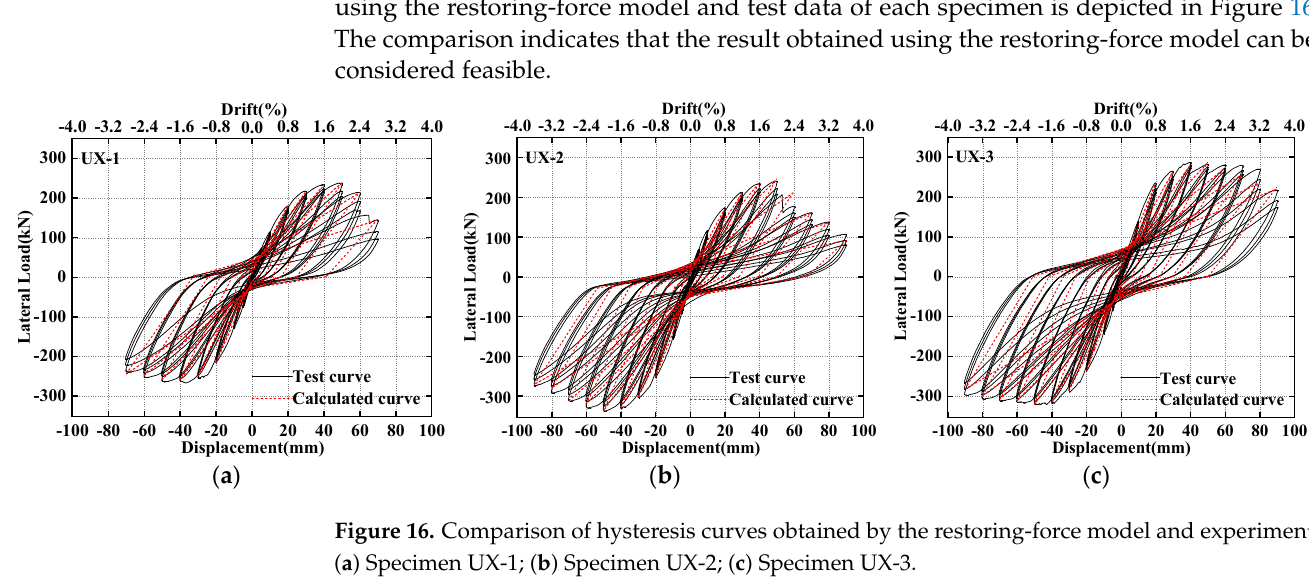
( f ) Figure 15. Regression analyses of stiffness-degradation curves: ( a ) K 1 /K 0+ ; ( b ) K 2 /K 0- ; ( c ) K 3 /K 0- ; ( d ) K 4 /K 0- ; ( e ) K 5 /K 0+ ; ( f ) K 6 /K 0+ . Table 5. The regression equation for each degradation stage. Stage Regression Equation K 1 /K 0+